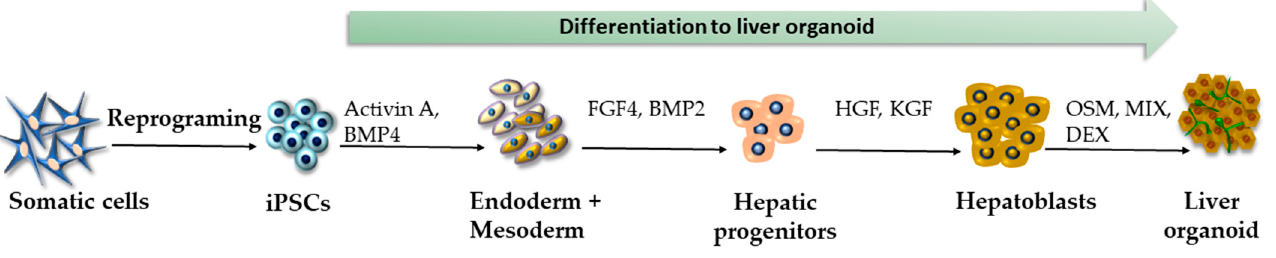
Figure 4. Generation of liver organoids according to the protocol by Wu et al.